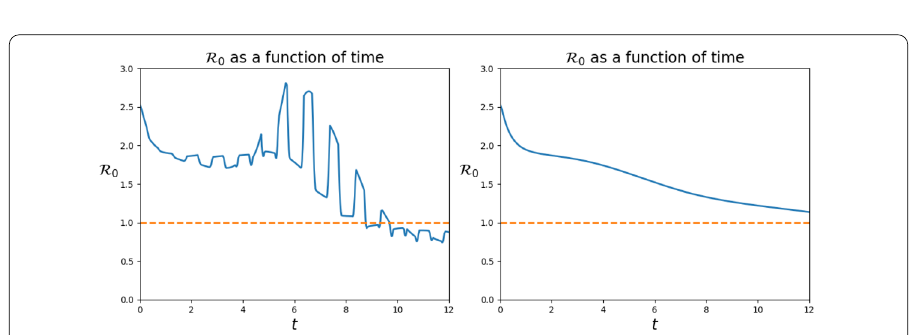
Figure 18 Value of the R o ( t ) index corresponding to the solution to (8) on a 12 days time interval. The commuters’ movements clearly boost the spreading of the virus